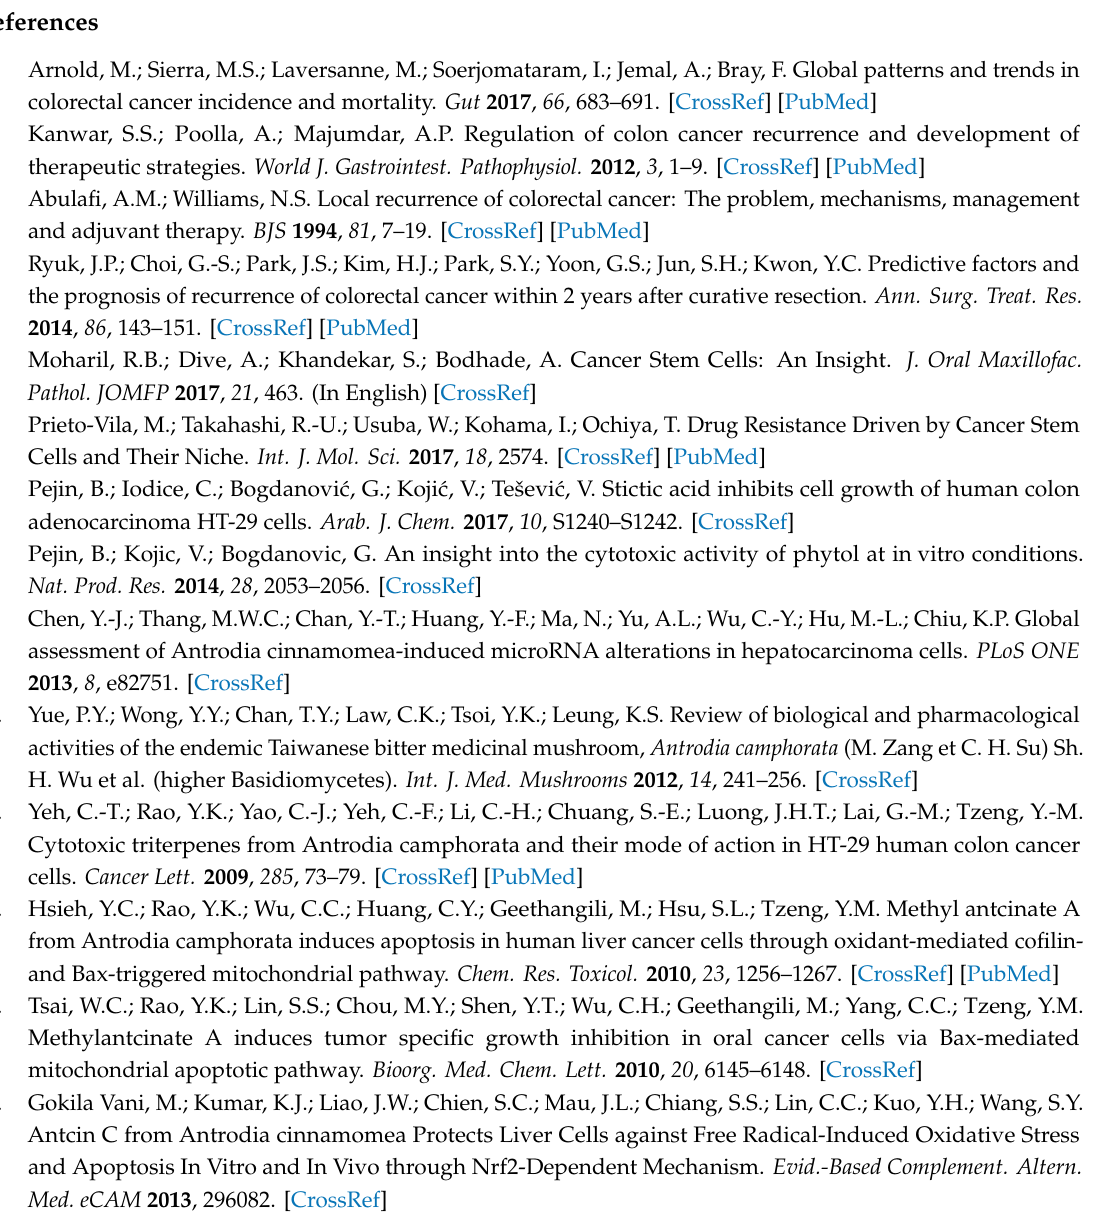
Table S1: Primer sequences of